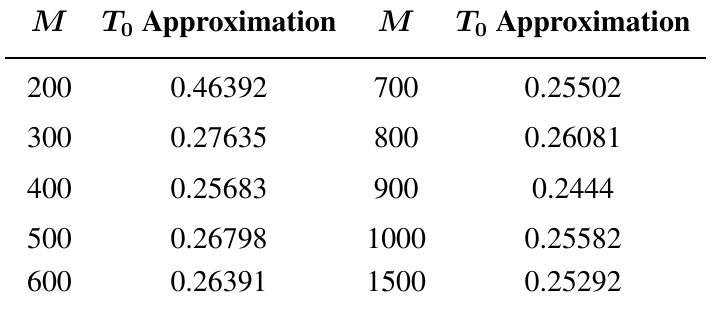
Table 4. Approximations of T in the four-pole example with perturbation 10 − 8 sin(10 πx ) 0 using extrapolations for various M